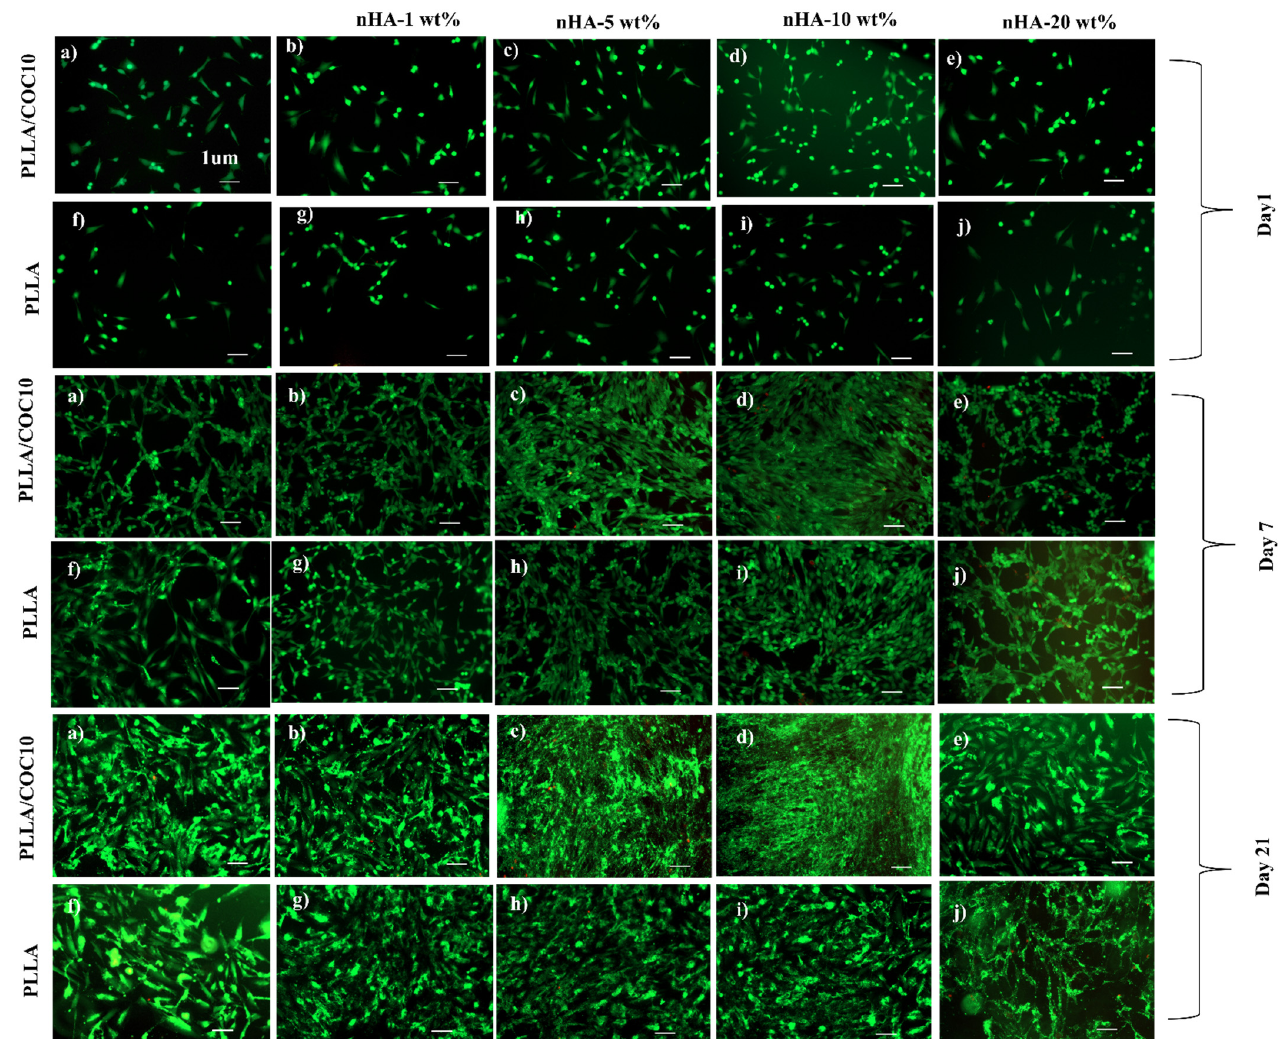
Figure 8. LIVE/DEAD assay for the vitality of MC3T3-E1 pre-osteoblasts cultivated on polymer, PLLA/COC10-nHA, and PLLA/nHA over time. The scale bar is 1 μ m in all the images. Nanocomposites had nHA in 1 wt%, 5 wt%, 10 wt%, and 20 wt%. On the surface of the PLLA/COC10-nHA, cells adhered more as compared to PLLA/nHA at day 1 ( a – j ). The cells of day 14 ( a – j ) were building an interconnected network. Multilayer cells were found on day 21 ( a – j ) and demonstrated good cytocompatibility.